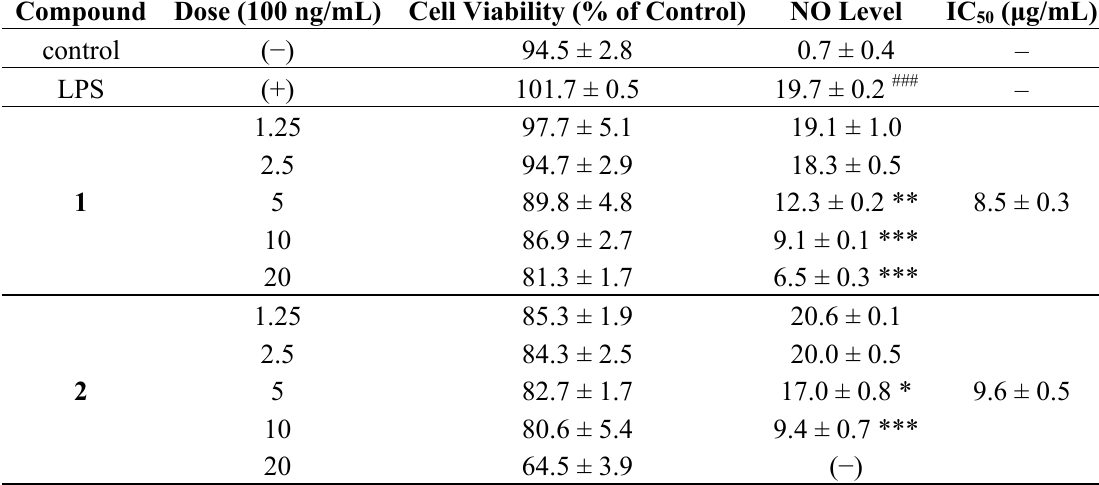
Table 1. Inhibitory effects of compounds 1 and 2 from the leaves of Michelia compressa var. formosana on LPS-induced Nitric Oxide (NO) production in RAW 264.7 cells.